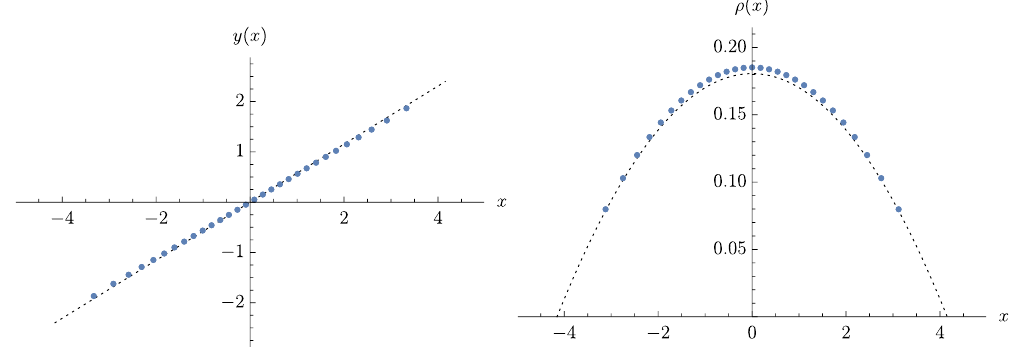
Figure 1 . Numerical solution for the eigenvalues (cid:21) i = N 1 = 3 ( x i + iy i ) (left) and eigenvalue density (cid:26) ( x ) (right) for N = 30 and k = 1. The leading order solution, (2.5), is shown by the dotted line. or k (cid:12)xed when extrapolating to large N . We mainly focus on the (cid:12)xed k limit, although we have also compared our numerical results with those obtained by holding t